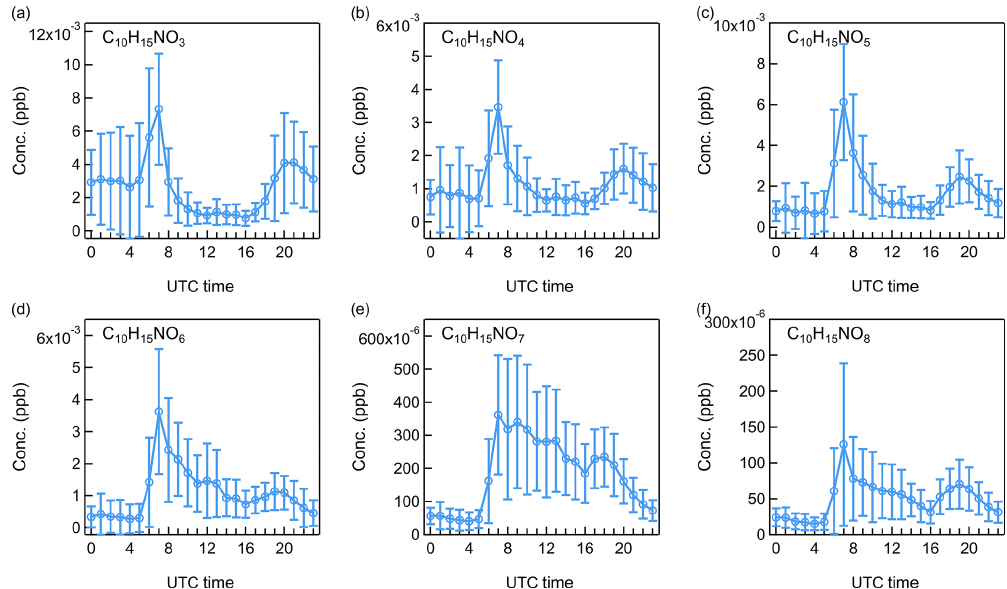
Figure 11. Diurnal patterns of monoterpene-derived organic nitrates: (a) C 10 H 15 NO 3 , (b) C 10 H 15 NO 4 , (c) C 10 H 15 NO 5 , (d) C 10 H 15 NO 6 , (e) C 10 H 15 NO 7 , and (f) C 10 H 15 NO 8